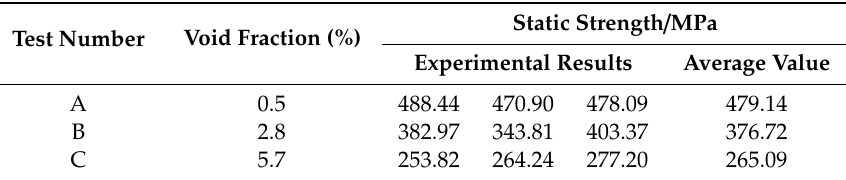
Table 1. Static strength tensile experimental results.